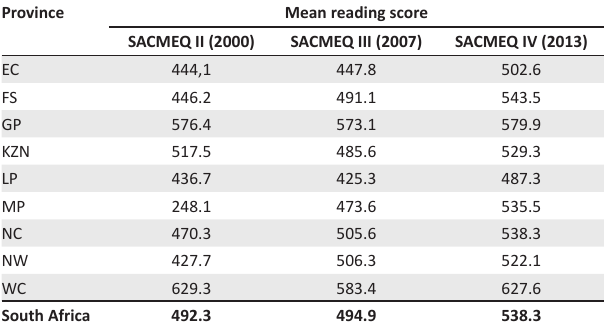
TABLE 3: Mean Rasch scores in Southern and East African Consortium for Monitoring Educational Quality II, III and IV for South African Grade 6 learners in reading tests in 2000, 2007 and